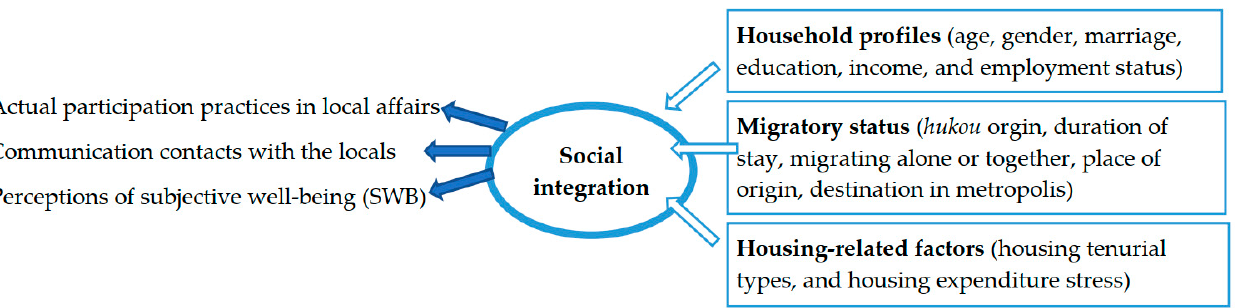
Figure 1. Housing tenure types accessible for migrants in the Beijing metropolis in China ( a ) com- mercial housing for self-owning or renting; ( b ) dormitory provided by employers in the industrial park; ( c ) public rented housing prepared for talented migrant workers; ( d ) “urban village” housing. Photos were taken by authors.